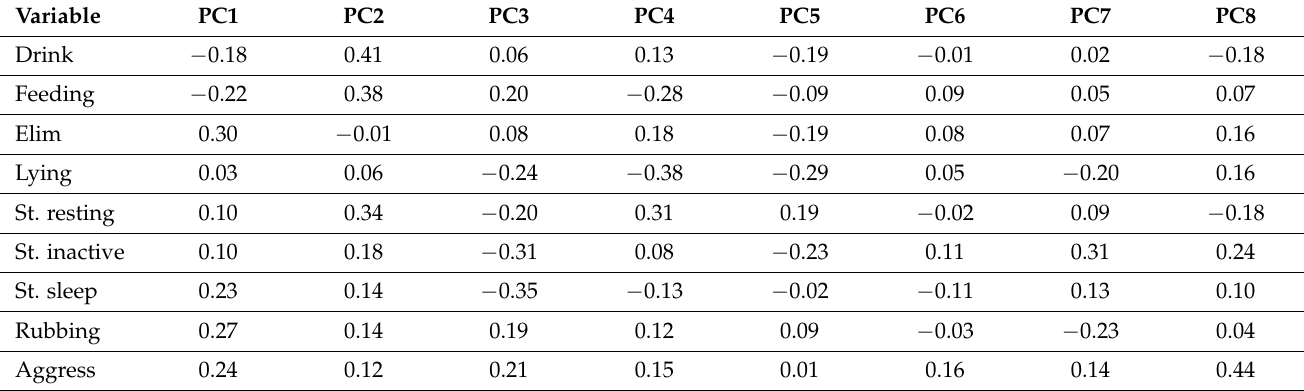
Table 3. Eight principal components (PC) for behaviours of TBRs in stables ( n =